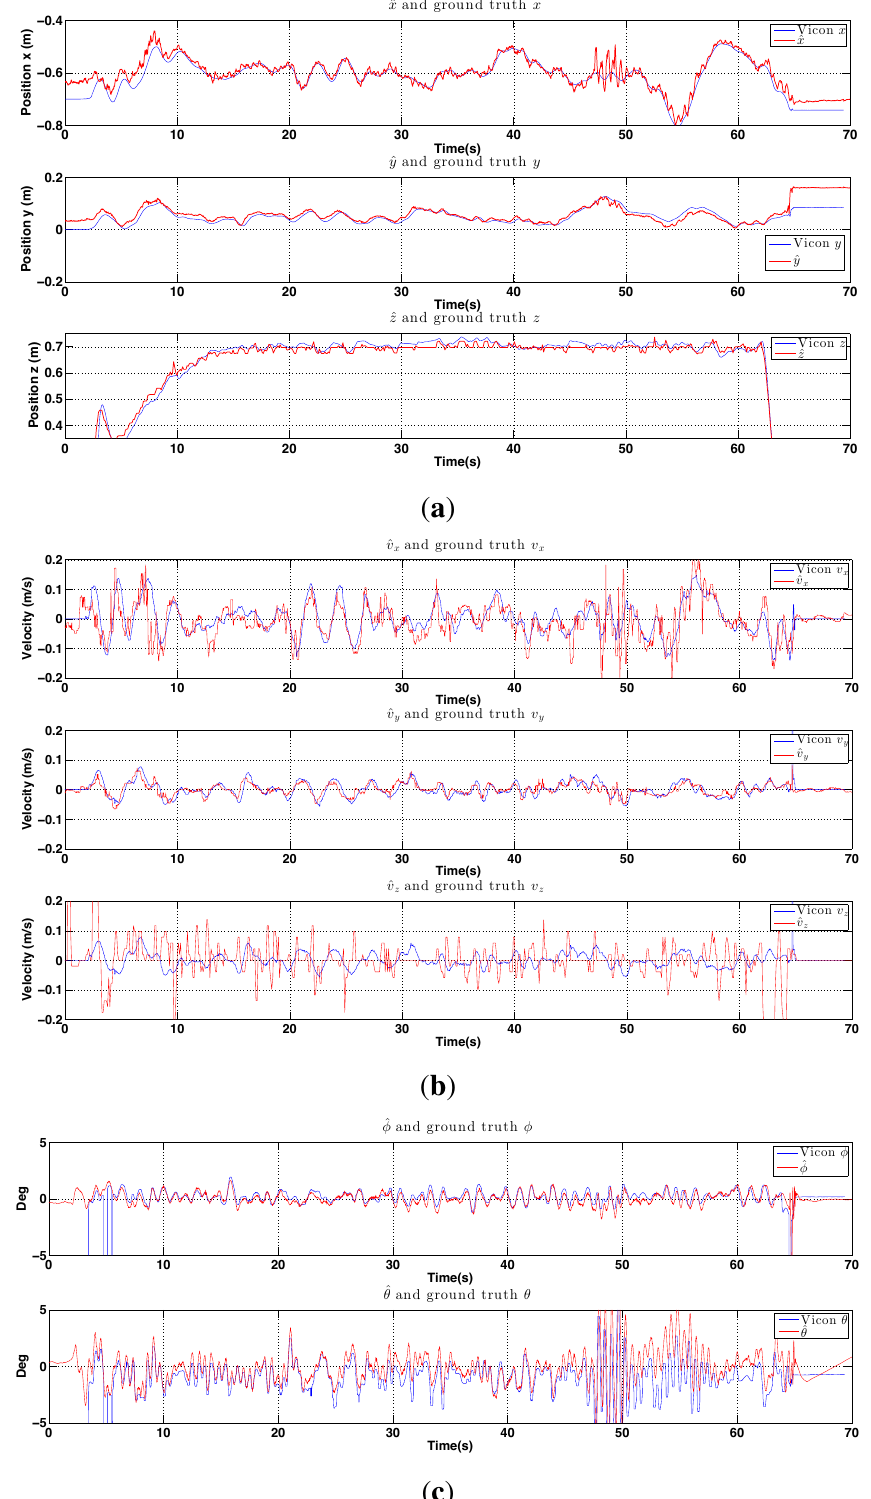
Figure 24. Experimental results for indoor PBVS-based hovering. All states are shown at the same scale. The performance evaluation of the state estimator is summarised in Figure 22. ( a ) Position estimation (red) with ground truth (blue). Note that z-axis is inverted for visualization; ( b ) Velocity estimation (red) with ground truth (blue), W ˆ˙ x , W ˆ˙ y and W ˆ˙ z ; ( c ) Attitude estimation (red) with ground truth (blue), roll ˆ φ and pitch ˆ θ